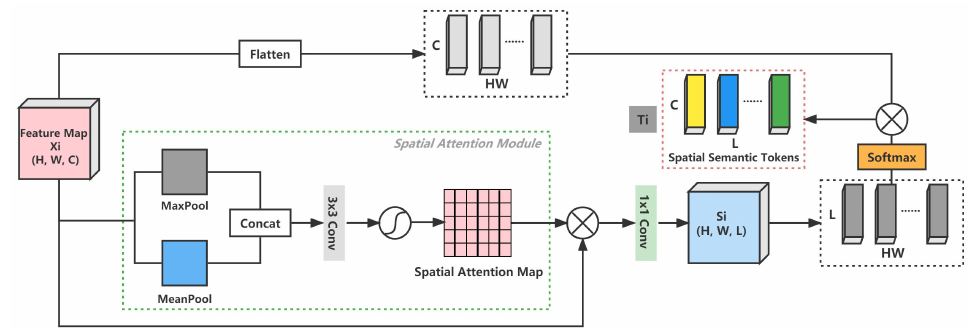
Figure 3. The diagram of the Spatial Semantic